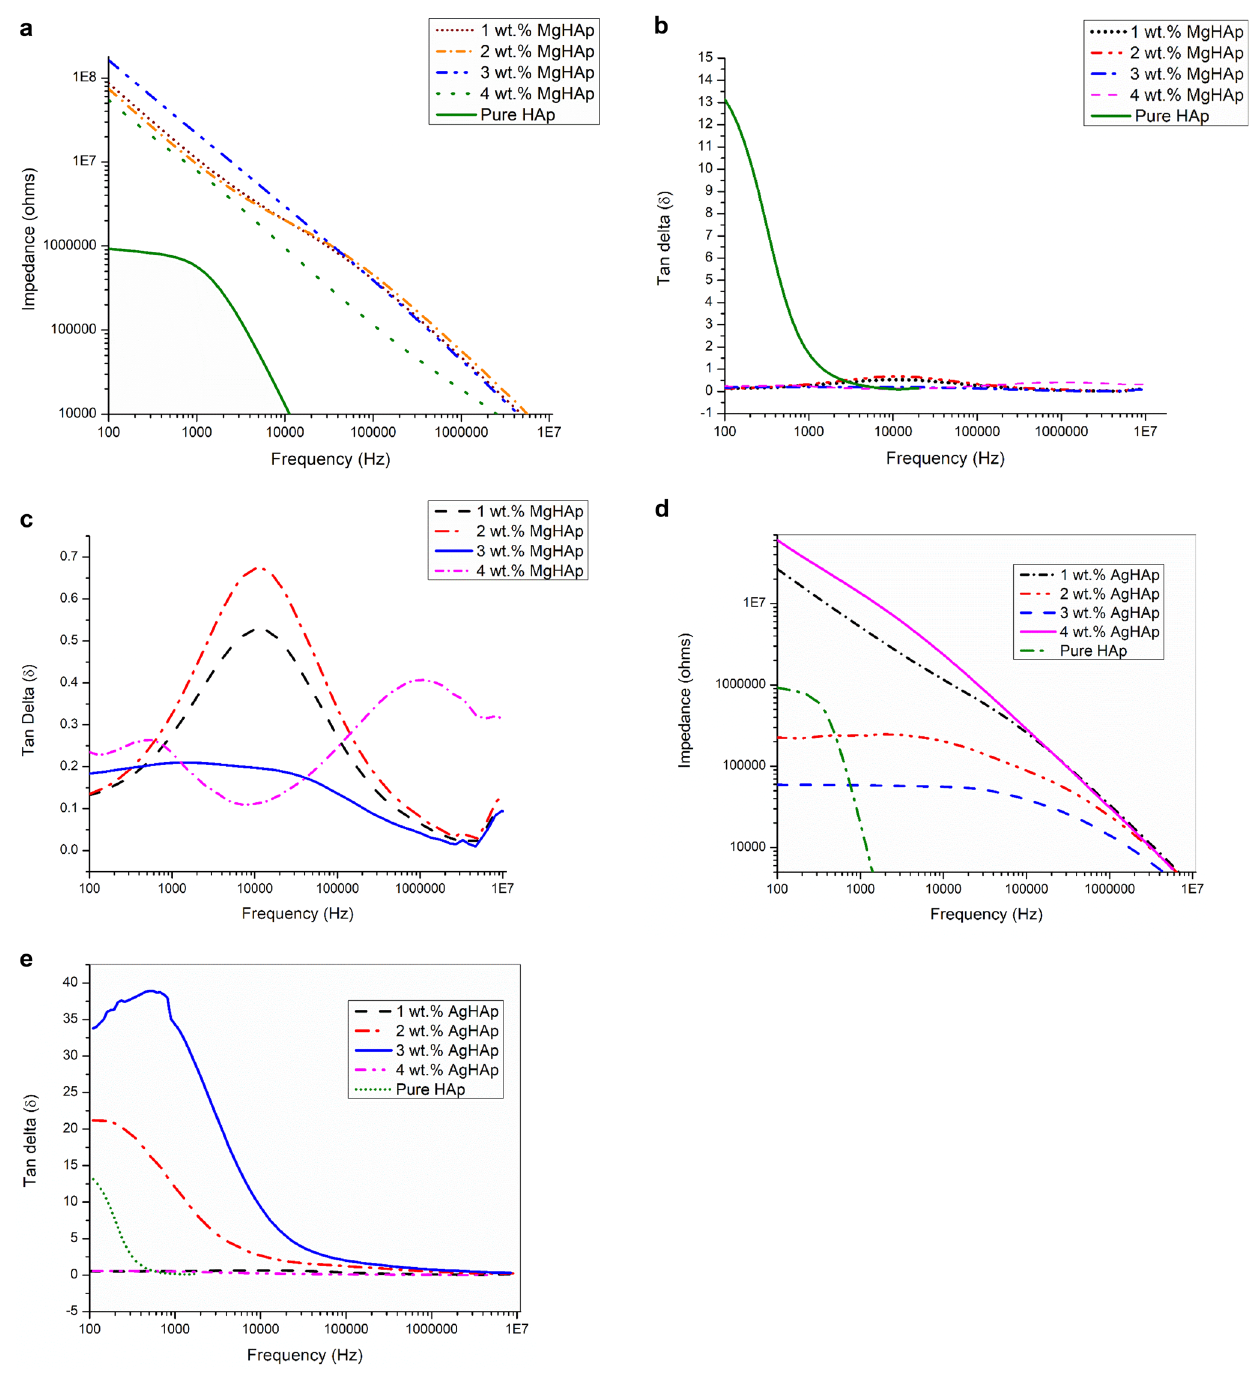
Fig. 6 a The Bode plot for MgHAp samples. b The dielectric loss for MgHAp samples. c The magni fi ed image for dielectric loss for MgHAp samples. d The Bode plot for all AgHAp samples. e The dielectric loss for AgHAp